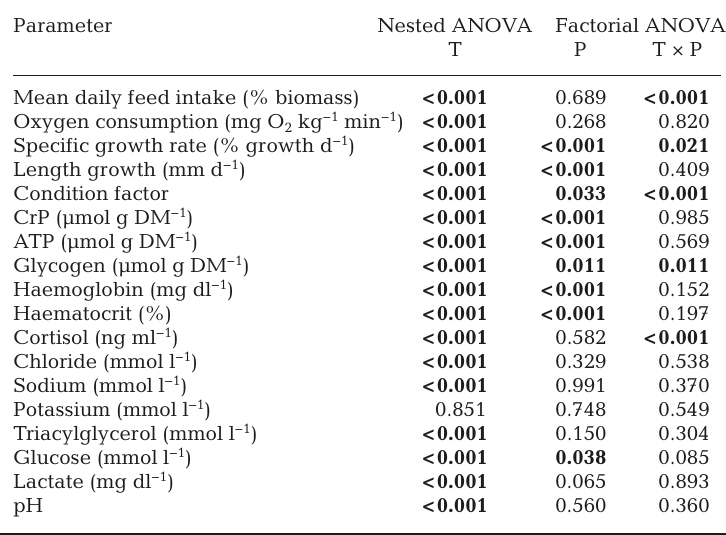
Table 1. p-values of growth performance and condition (specific growth rate, length growth, condition factor, mean daily feed intake, oxygen consump- tion), white muscle (creatine phosphate [CrP], ATP, glycogen), blood (haemo- globin, haematocrit) and plasma parameters (cortisol, chloride, sodium, triacyl- glycerol, glucose, lactate and pH) in Atlantic salmon Salmo salar for Figs. 2 to 7. Each parameter was tested in a nested ANOVA design (temperature [T], ploidy [P]) with tank as random factor, nested in ploidy and sampling point (temperature). Significant nested ANOVAs were followed by factorial ANOVAs (T × P) to detect possible interactions between the treatments. DM: dry mass. Values in bold indicate a significant effect (p <